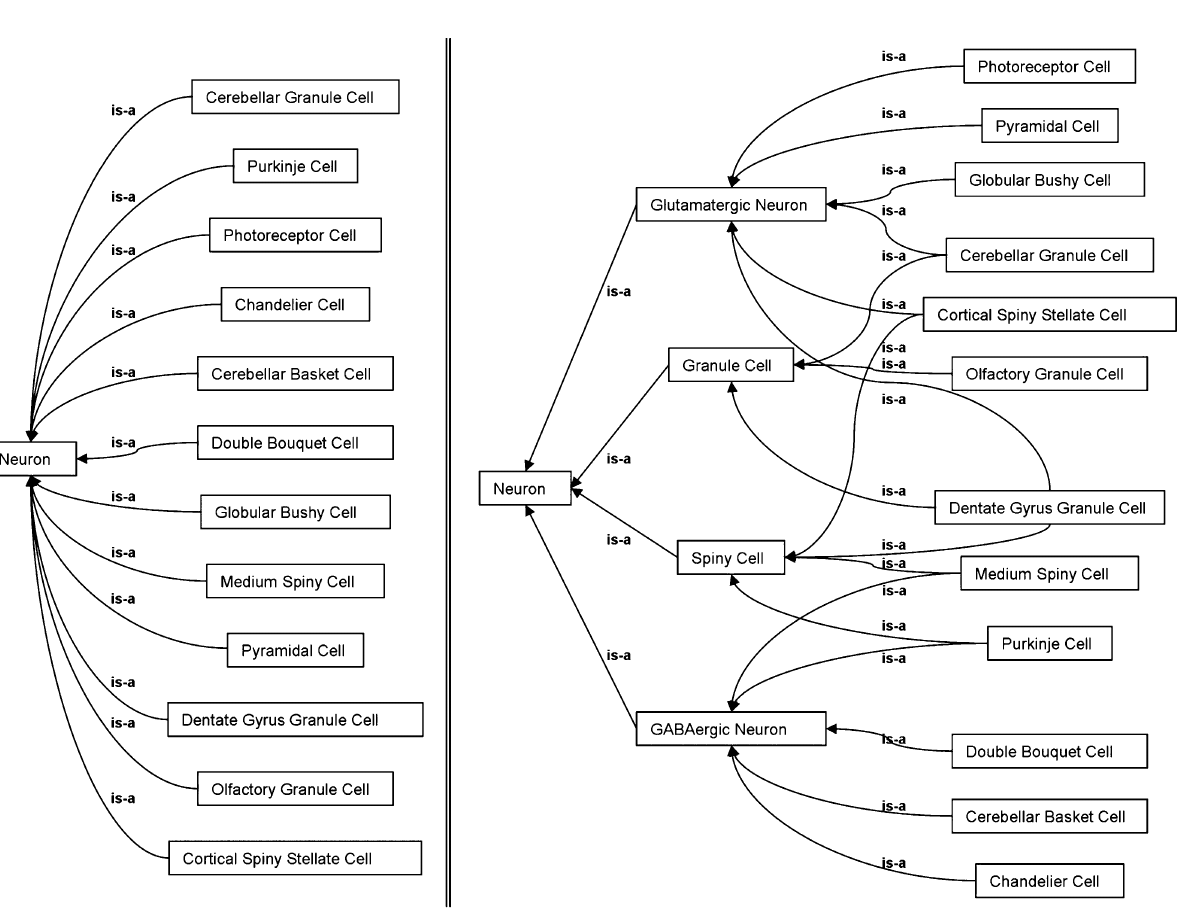
Figure 5. Inferred hierarchies using OWL . On the left, a subset of the hierarchy under the Neuron class prior to inference. On the right, the automatic reclassification of that subset under four user-defined groupings, Glutamatergic Neuron, GABAergic Neuron, Spiny Cell, Granule Cell, based on the properties of the cells